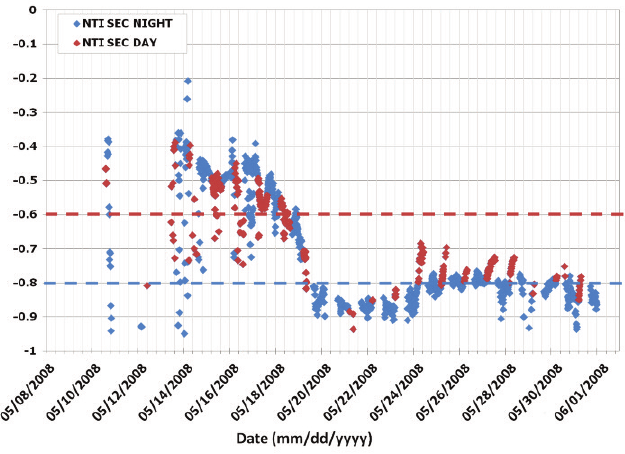
Figure 2. Normalized thermal index sequence computed for the SEVIRI data at the SEC. Red dots, day images; blue dots, night images.